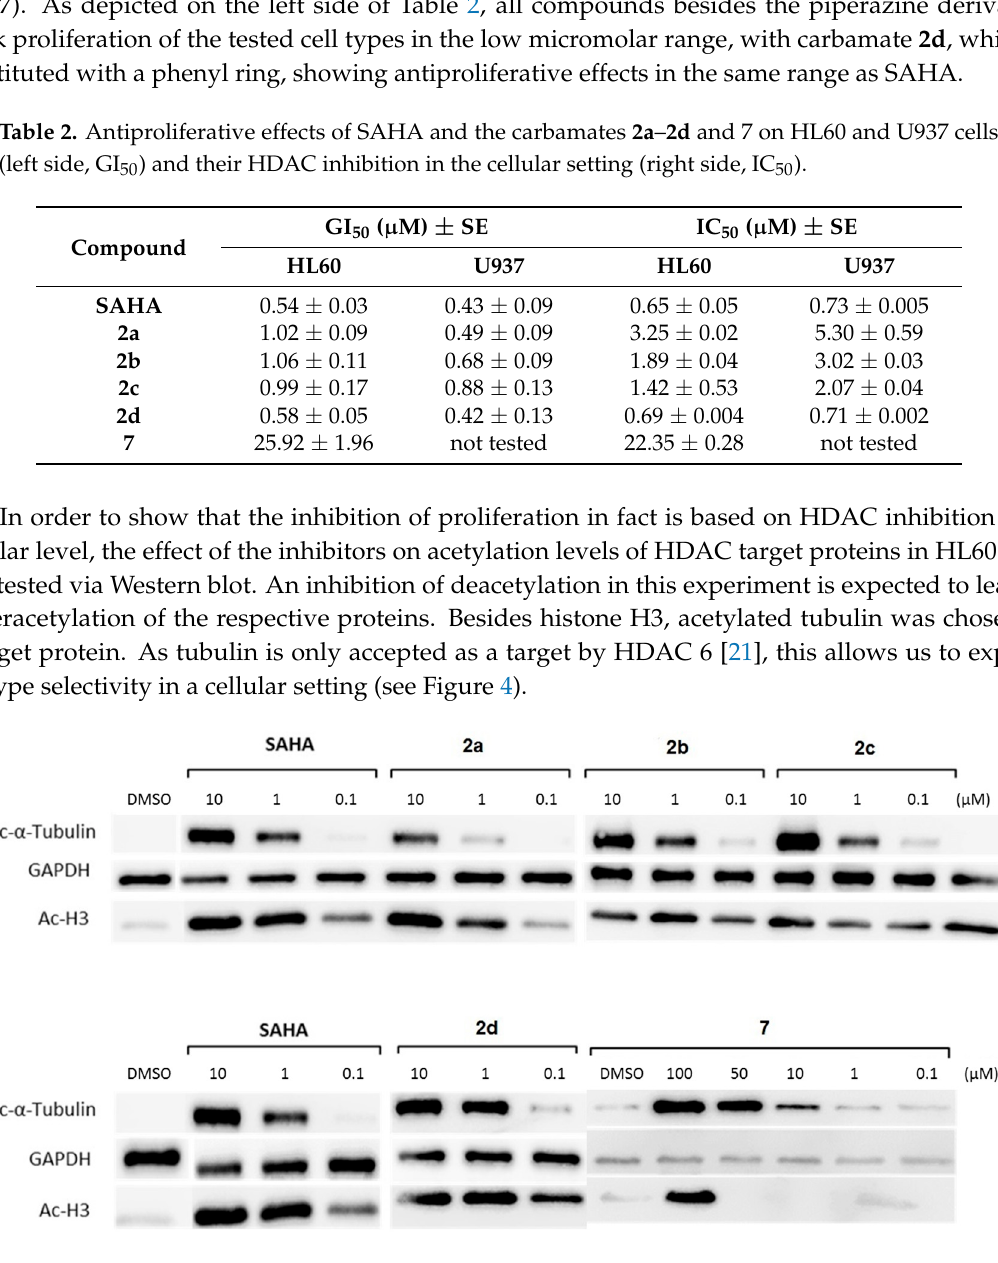
Figure 4. Detection of acetylation levels of H3 and tubulin after incubation of HL60 cells with SAHA and the carbamates 2a – 2d and 7 . GAPDH was used as a loading control.